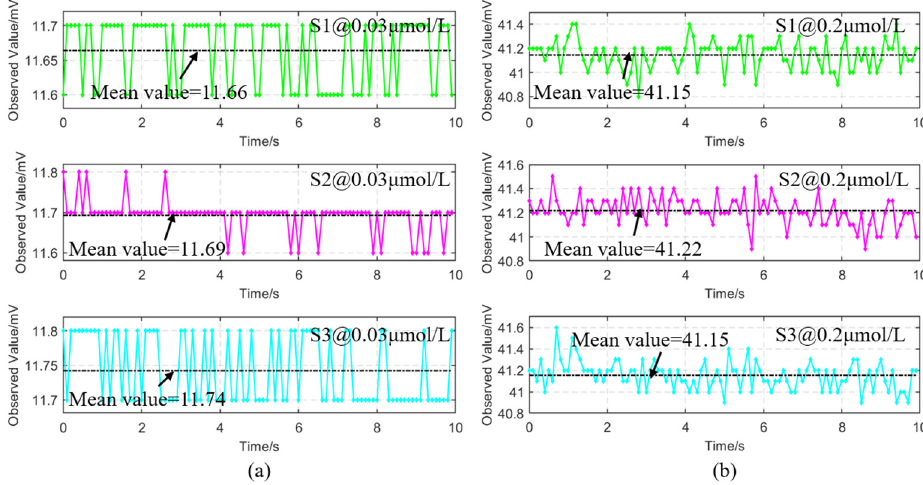
Figure 8. Errors in the measurements of three samples at ( a ) 0.03 µmol/L, ( b ) 0.2 µmol/L.